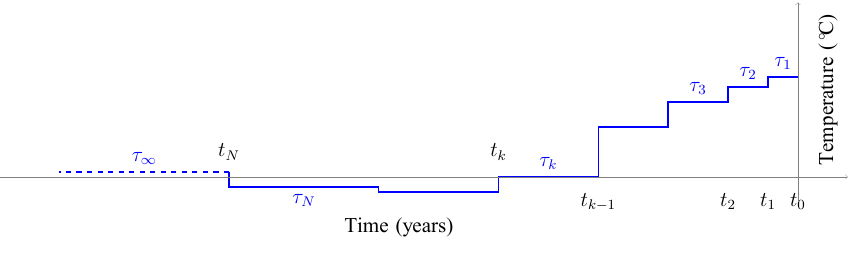
Figure 3. Example of a GST history parametrized by Eq.